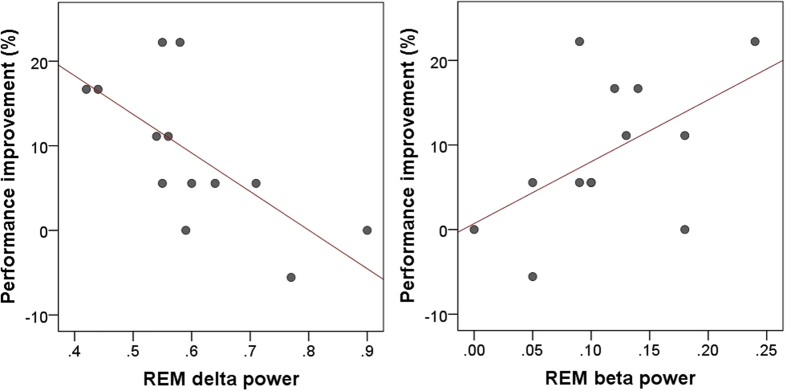
Relationship between performance improvement (the relative difference between pre-sleep and post-sleep performance) in the learning task, and relative delta power (left) as well as beta power (right) during post-learning REM sleep.